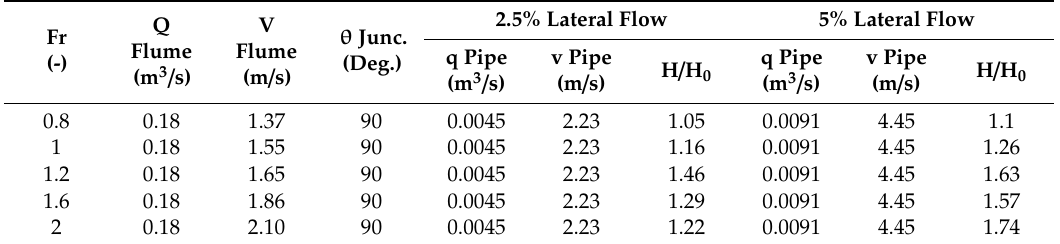
Table 4. Experimental results for the 90° junction in the narrow channel. Table 3. Experimental results for the 90 ◦ junction in the wide